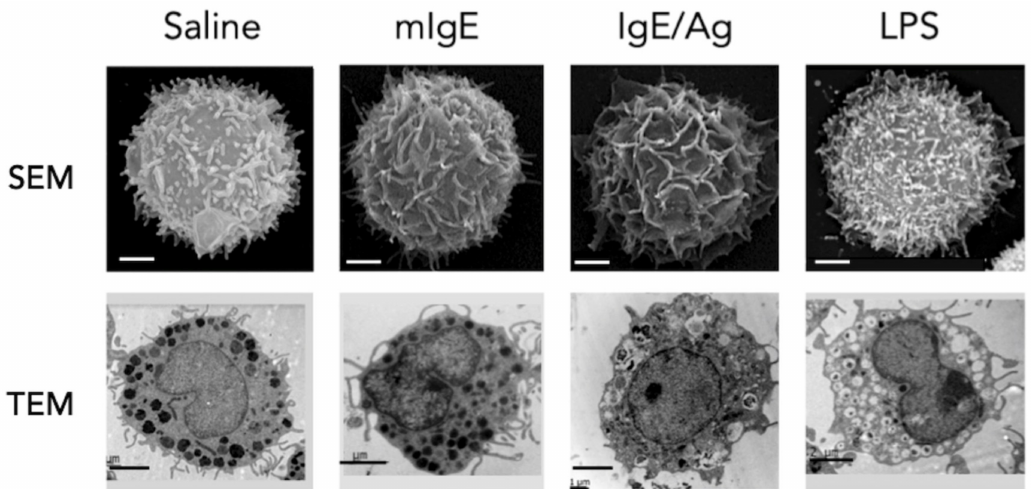
Figure 1. Plasticity on MCs responses elicited by distinct stimuli. Mature bone marrow derived mast cells (BMMCs) were treated with saline solution (Saline), monomeric IgE (mIgE, 100 ng / mL), IgE / Ag complexes (3 ng / mL) and Escherichia coli LPS (B06 serotype, 500 ng / mL) for optimal times